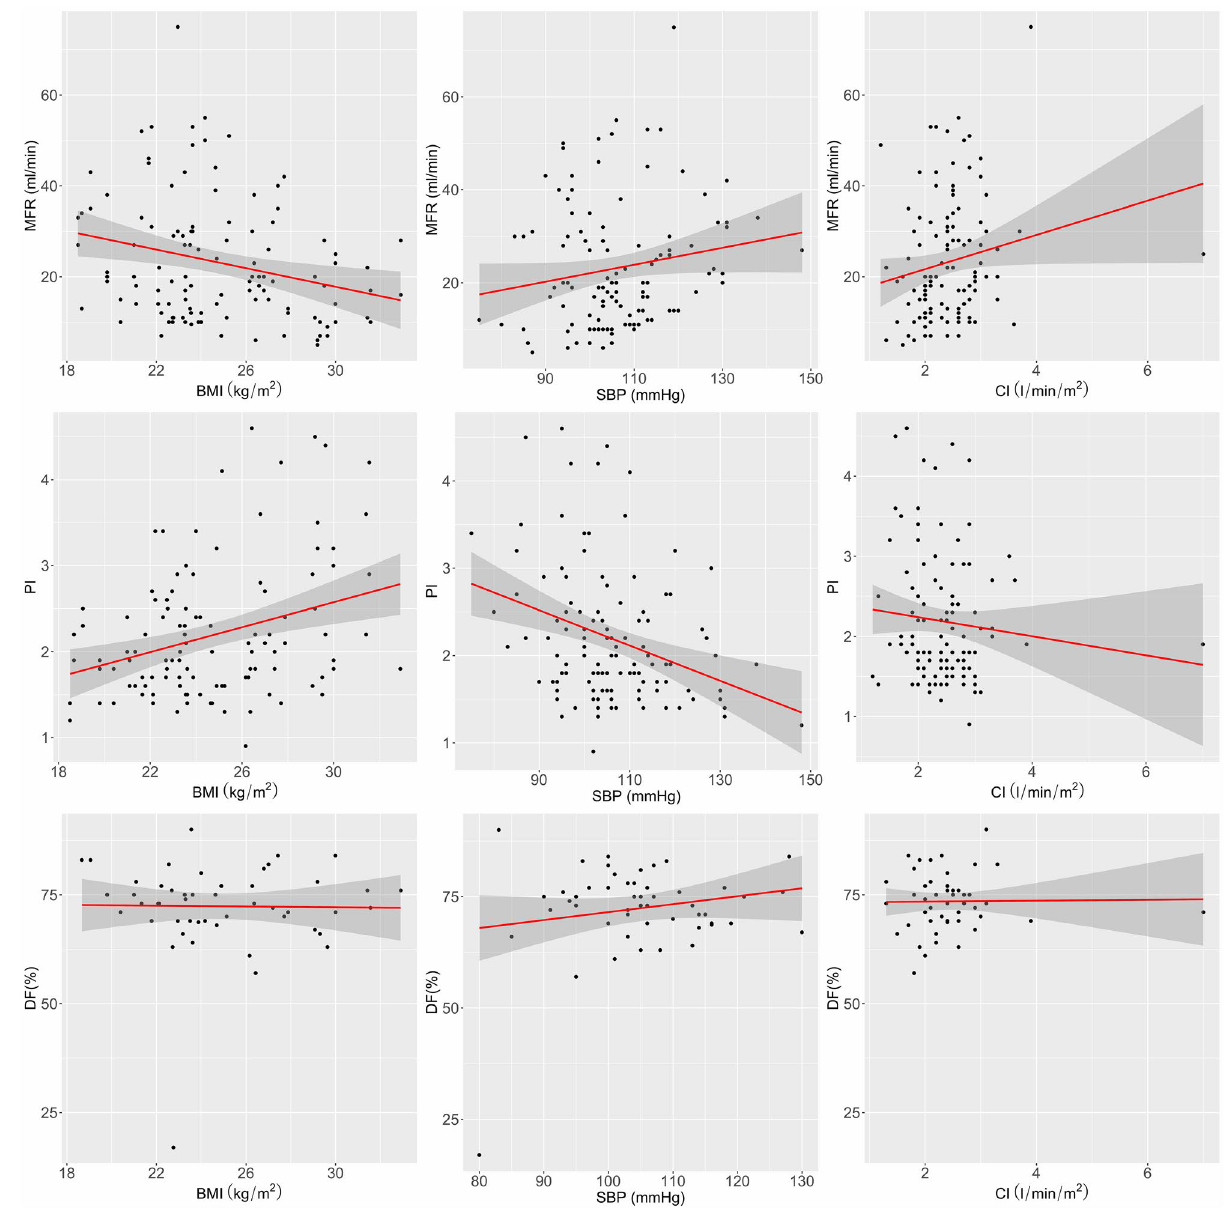
mass index, SBP systolic blood pressure, CI cardiac